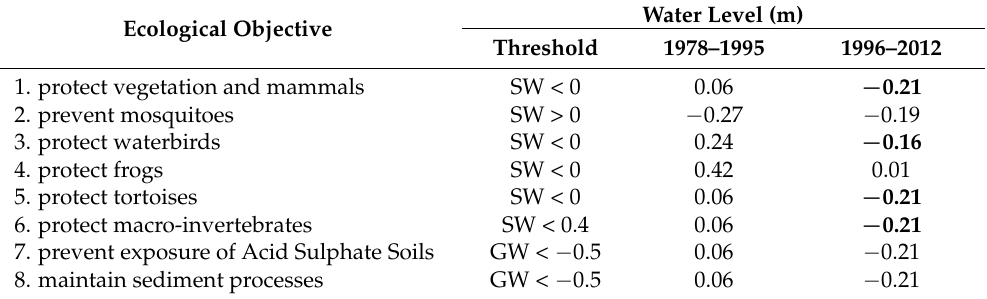
Table 2. Adaptation tipping points calculated with eq. 1 for each ecological function of Forrestdale Lake. Bold values indicate that the water level is below the threshold value and consequently result in an